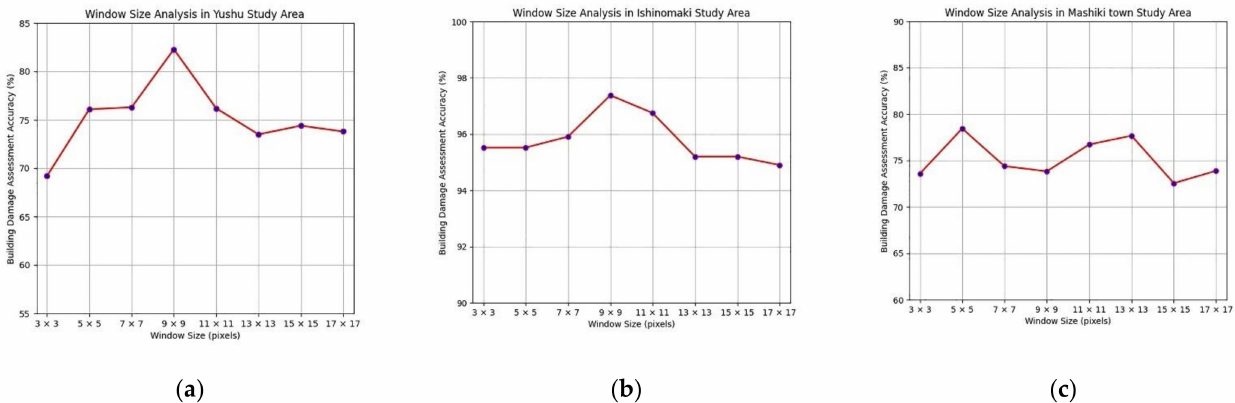
Figure 32. Overall accuracy (%) of building damage detection when using different window sizes to calculate texture features: ( a ) the results in the Yushu study site; ( b ) the results in the Ishinomaki study site; ( c ) the results in Mashiki town study